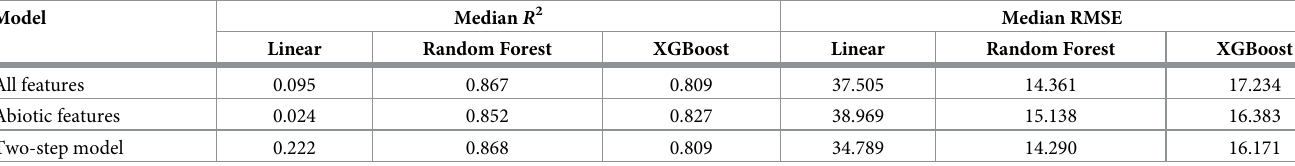
Table 2. Prediction errors for spatial application.